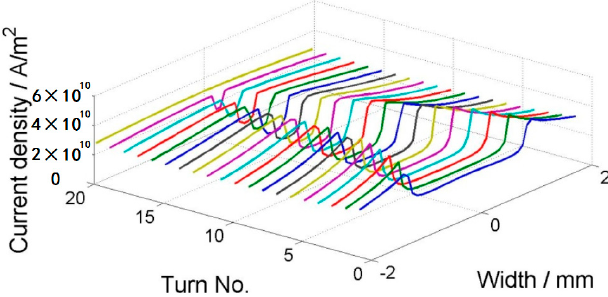
Figure 9. The current distribution when the applied current is 107.5 A and the external field is anti-phase 0.2 T.